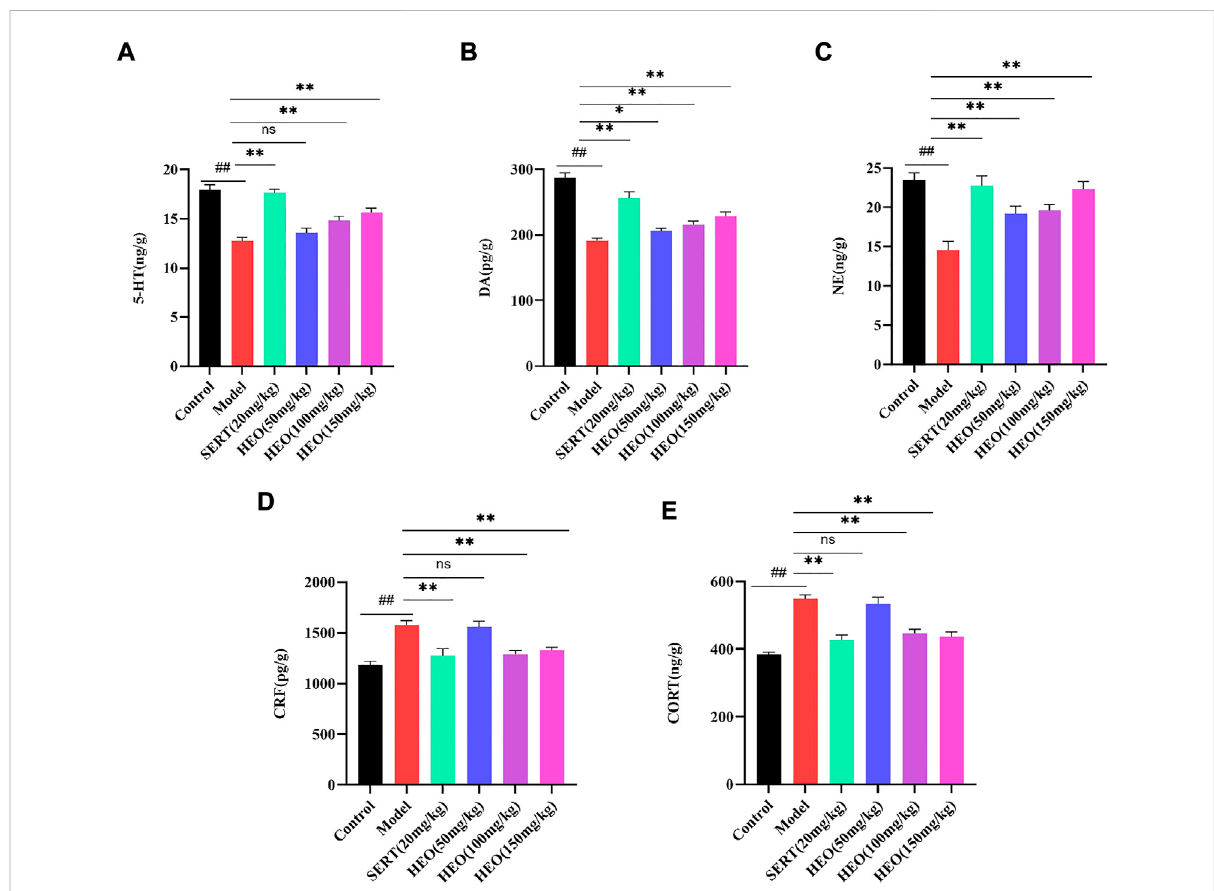
FIGURE 4 Effects of HEO on brain monoamine neurotransmitters in Hippocampus and HPA axis hormone levels. 5-HT (A) ; DA (B) ; NE level (C) ; CRF level (D) ; CORT level (E) . Data were expressed as mean ± SEM ( n = 8). ## p < 0.01 vs control group; * p < 0.05 and ** p < 0.01vs model group. HEO, the essential oil from the fruits of Z. bungeanum Maxim; 5-HT, serotonin; DA, dopamine; NE, norepinephrine; CRF, corticotropin-releasing factor; CORT,